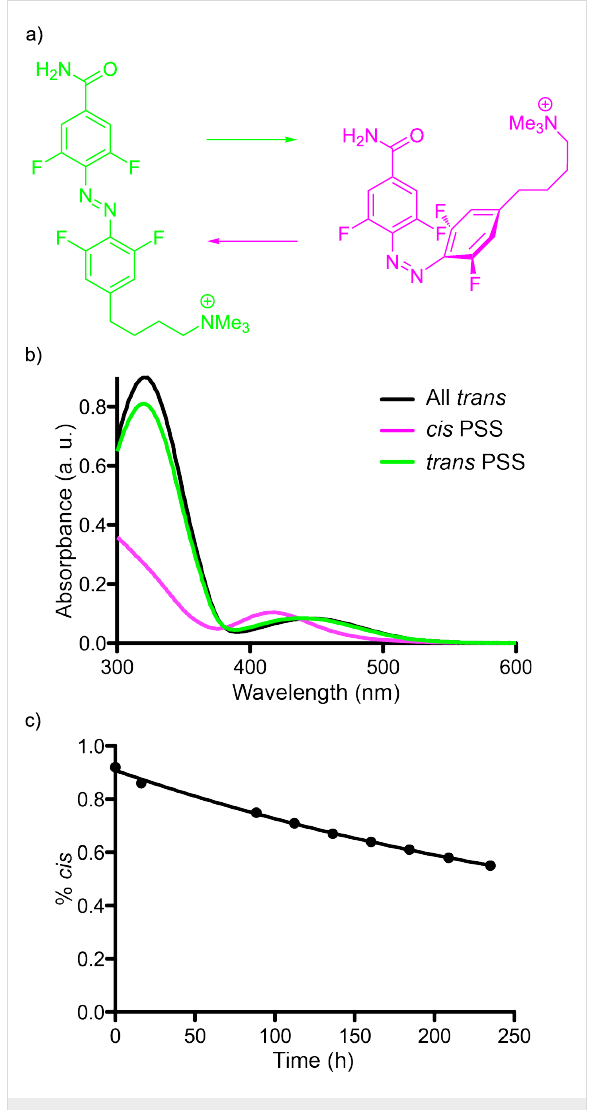
Figure 2: Photochemistry of 4FABTA ( 2 ), and thermodynamic stability in physiological buffer. a) Trans – cis photochemical reaction of 2 . b) Absorption spectra of all trans - 2 (black), cis - 2 PSS (from 532 nm laser), and trans - 2 PSS (from 405 nm laser) in HEPES (pH 7.4) at